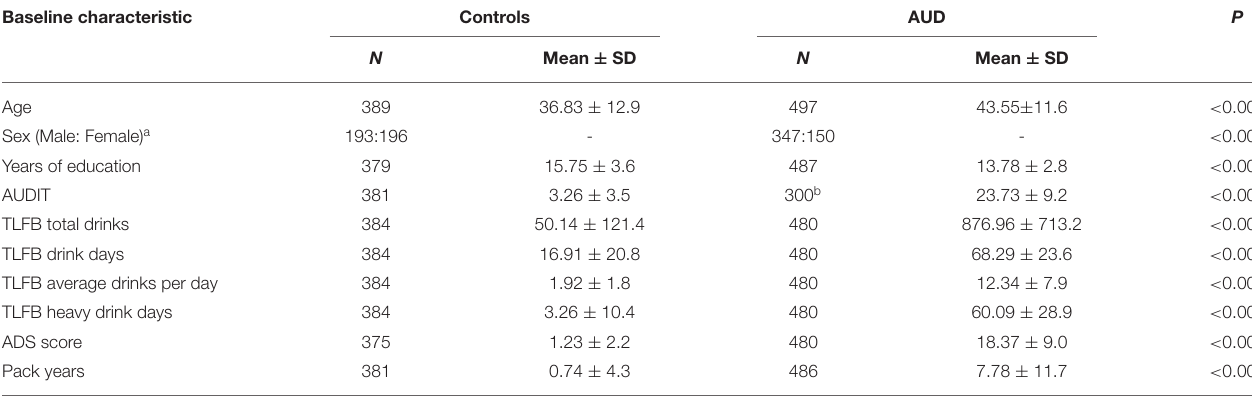
TABLE 1 | Sociodemographic and drinking characteristics of participants at baseline. Baseline characteristic